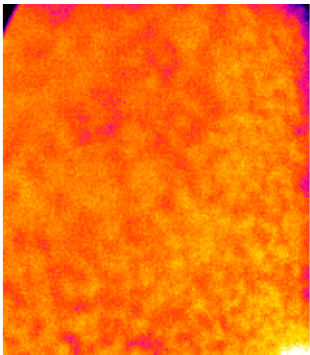
Figure 8. Slag inclusions and non-uniform distribution of resin in a glass/epoxy laminate; phase image taken with SC3000 camera.